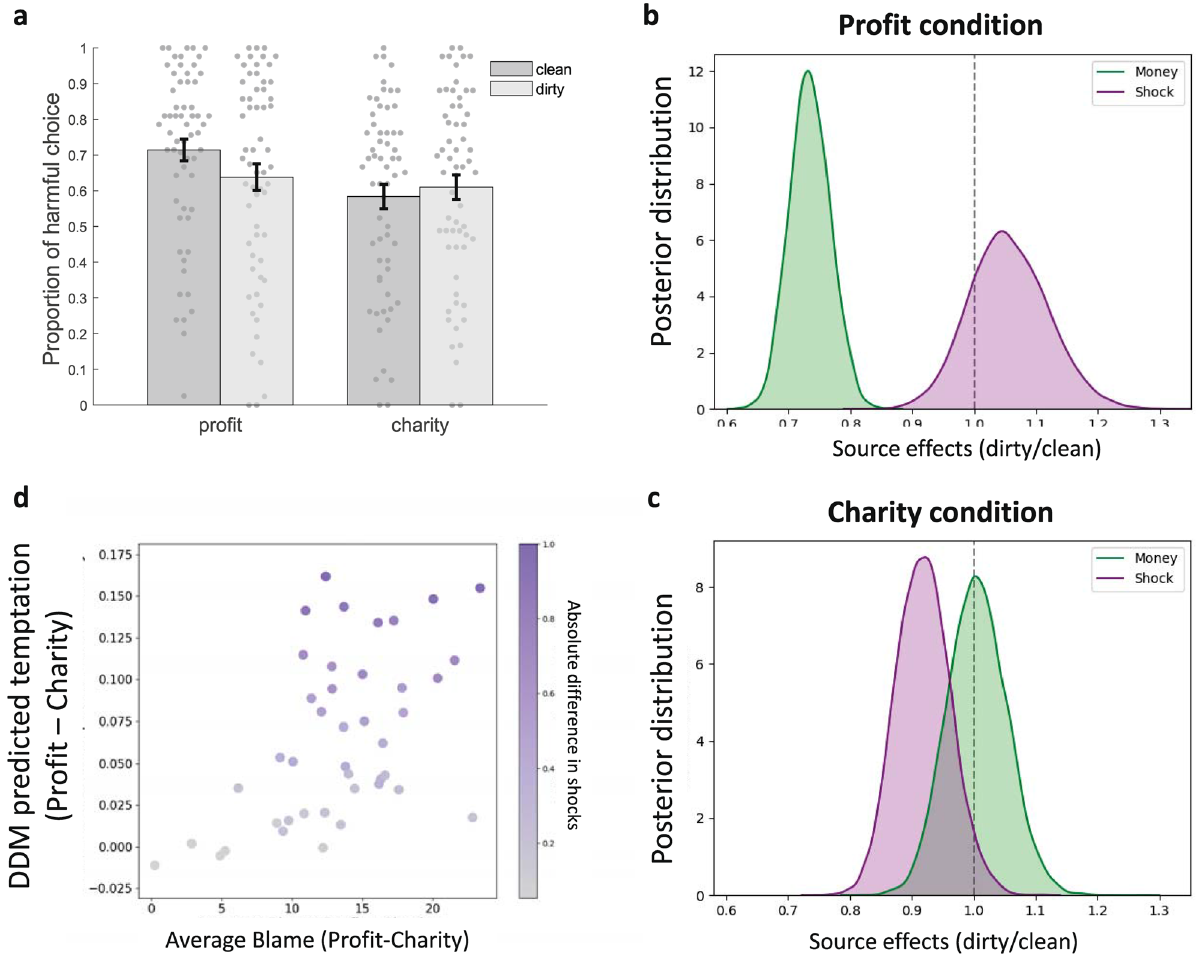
Figure 4. Source and destination effects on moral decision making. ( a ) Proportion of harmful choices made as a function of the source (dirty/clean) and destination (profit/charity) of the money. ( b ) In line with Study 1 (Fig. 2c) the weight on money was significantly lower when considering dirty relative to clean money for profit. ( c ) The weight on shocks was significantly lower when considering dirty relative to clean money for charity. ( d ) Scatterplot showing out-of-sample correlation between differences in blame judgments (Profit-Charity) in Study 2 (horizontal axis) and the estimated differences in value associated with choosing the more harmful option (Profit-Charity) in Study 3 (vertical axis). Each dot represents a possible combination of money and shocks offers. Dots are color coded according to the highest/lowest shock offers. Error bars represent standard error of the